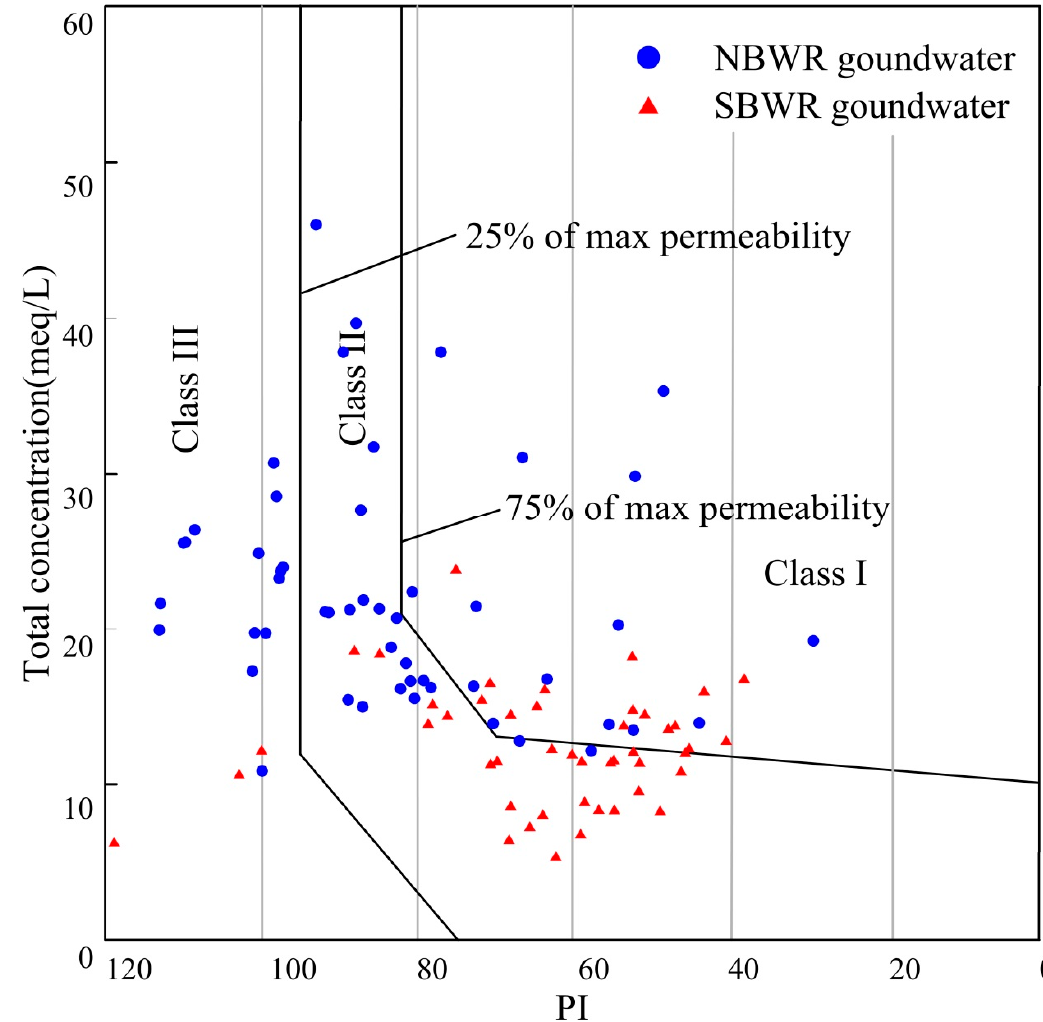
Figure 7. Doneen diagram for assessing irrigation water quality.